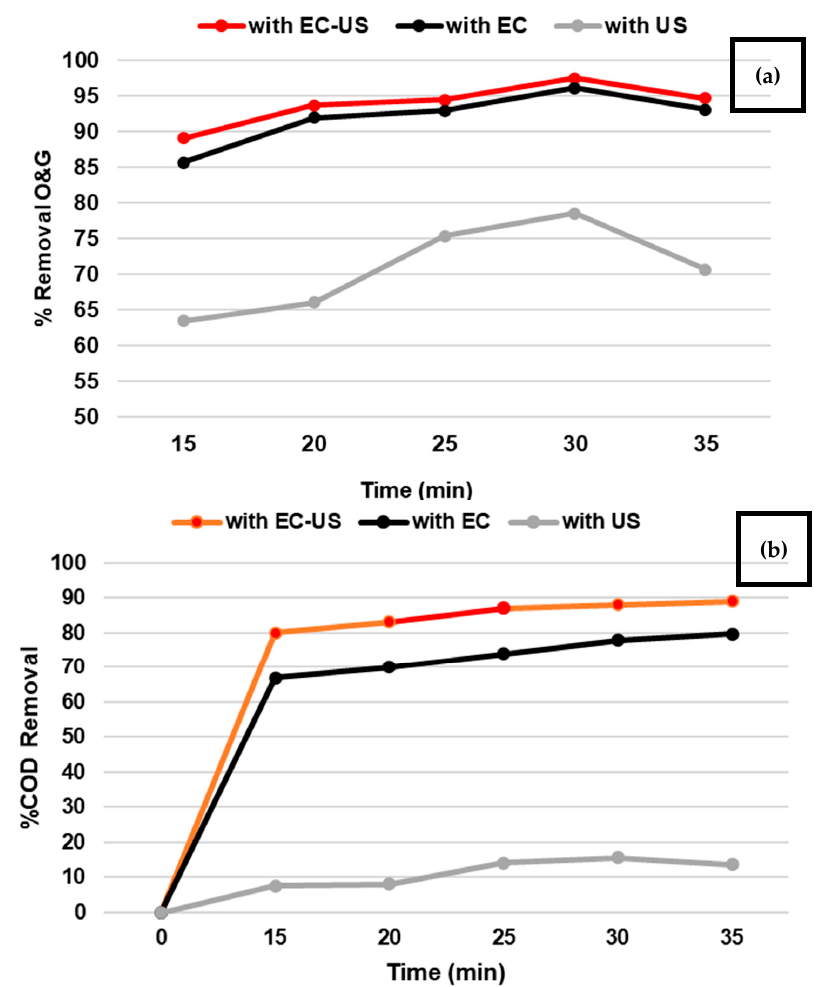
Figure 6. Comparison of US, EC, and US-EC processes on ( a ) O&G (%) and ( b ) COD removal (%), with optimum operating condition: 2 cm interelectrode distance and 50 A/m 2 current density.